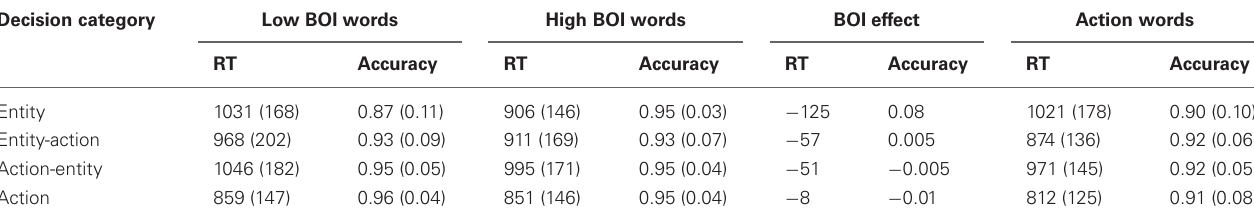
Table 3 | Mean (SD) RT and accuracy for low-BOI words, high-BOI words, and action words. Decision